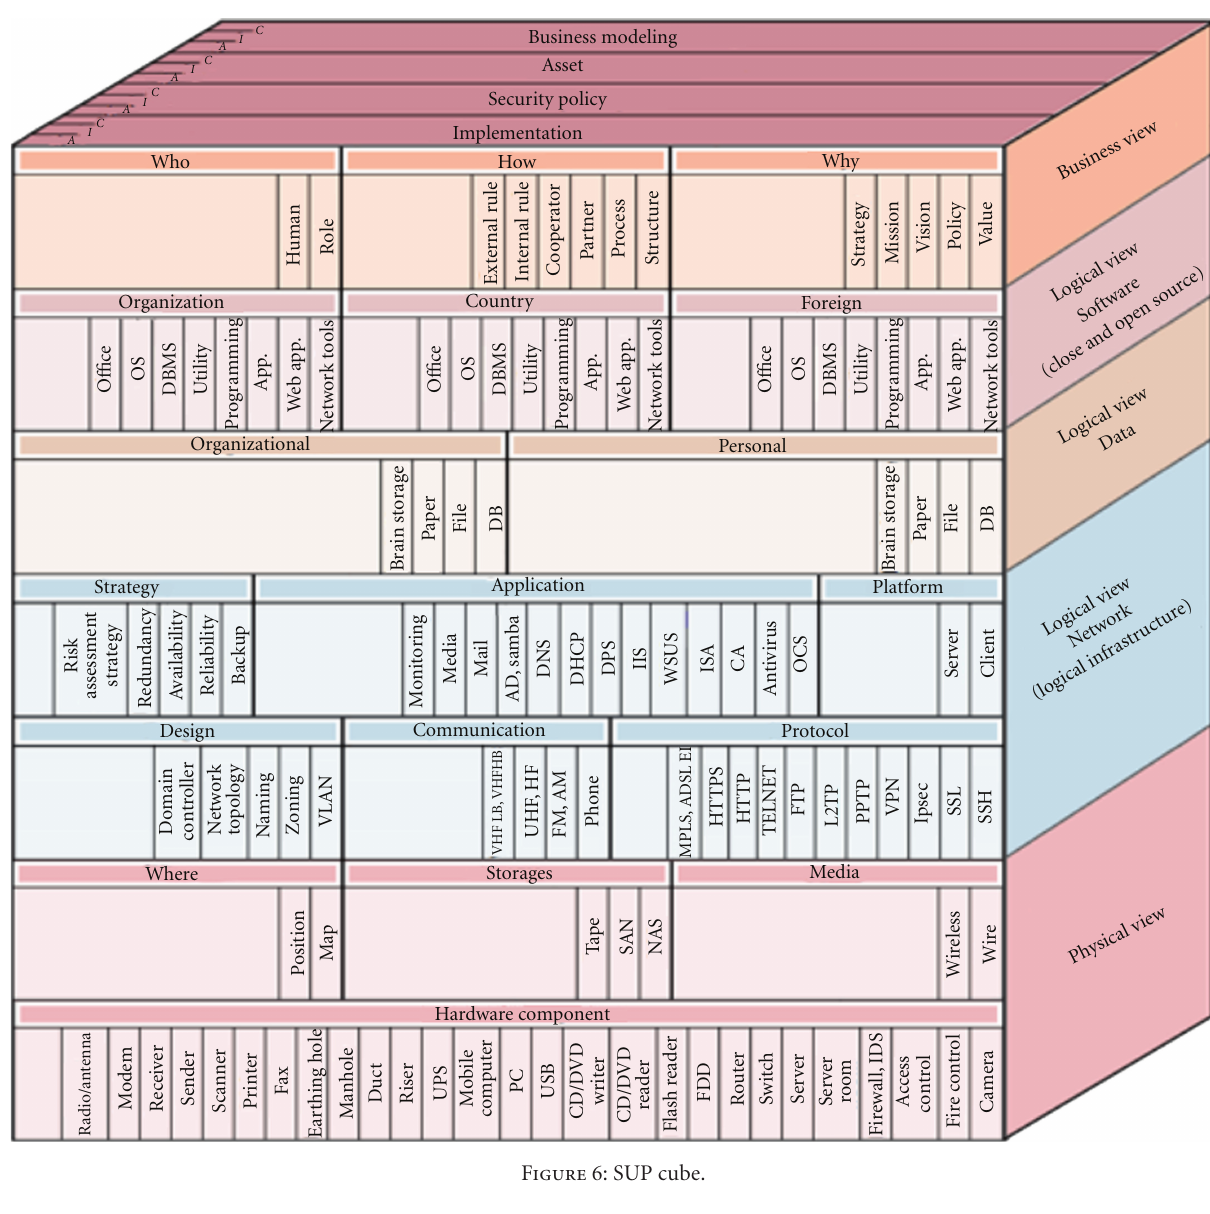
Figure 6: SUP cube.